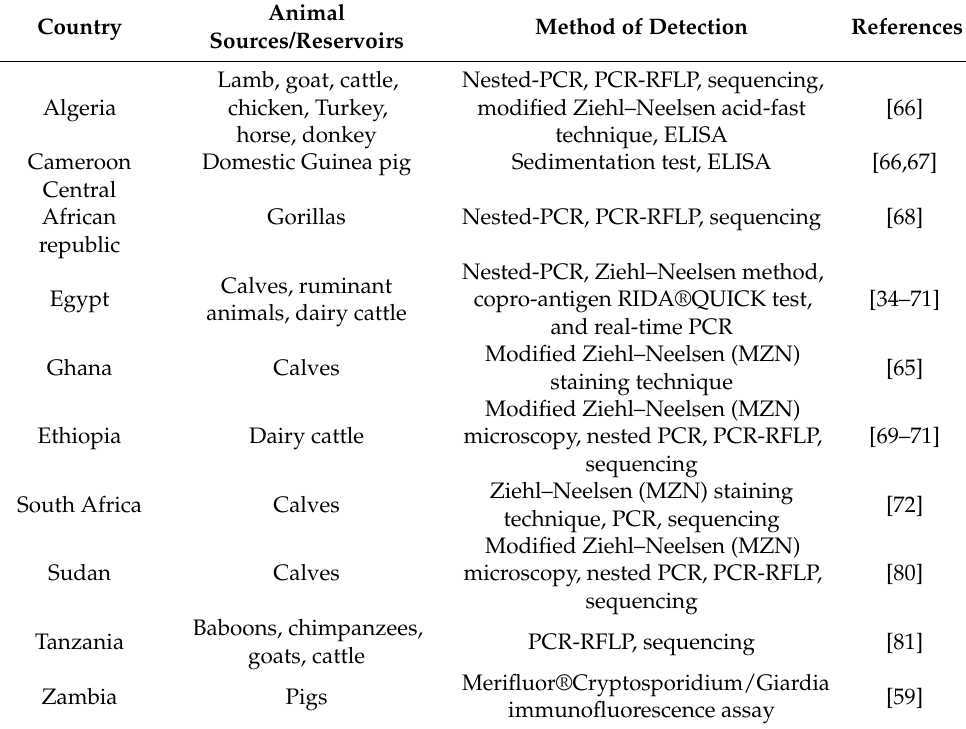
Table 4. Some animal reservoirs of Cryptosporidium in